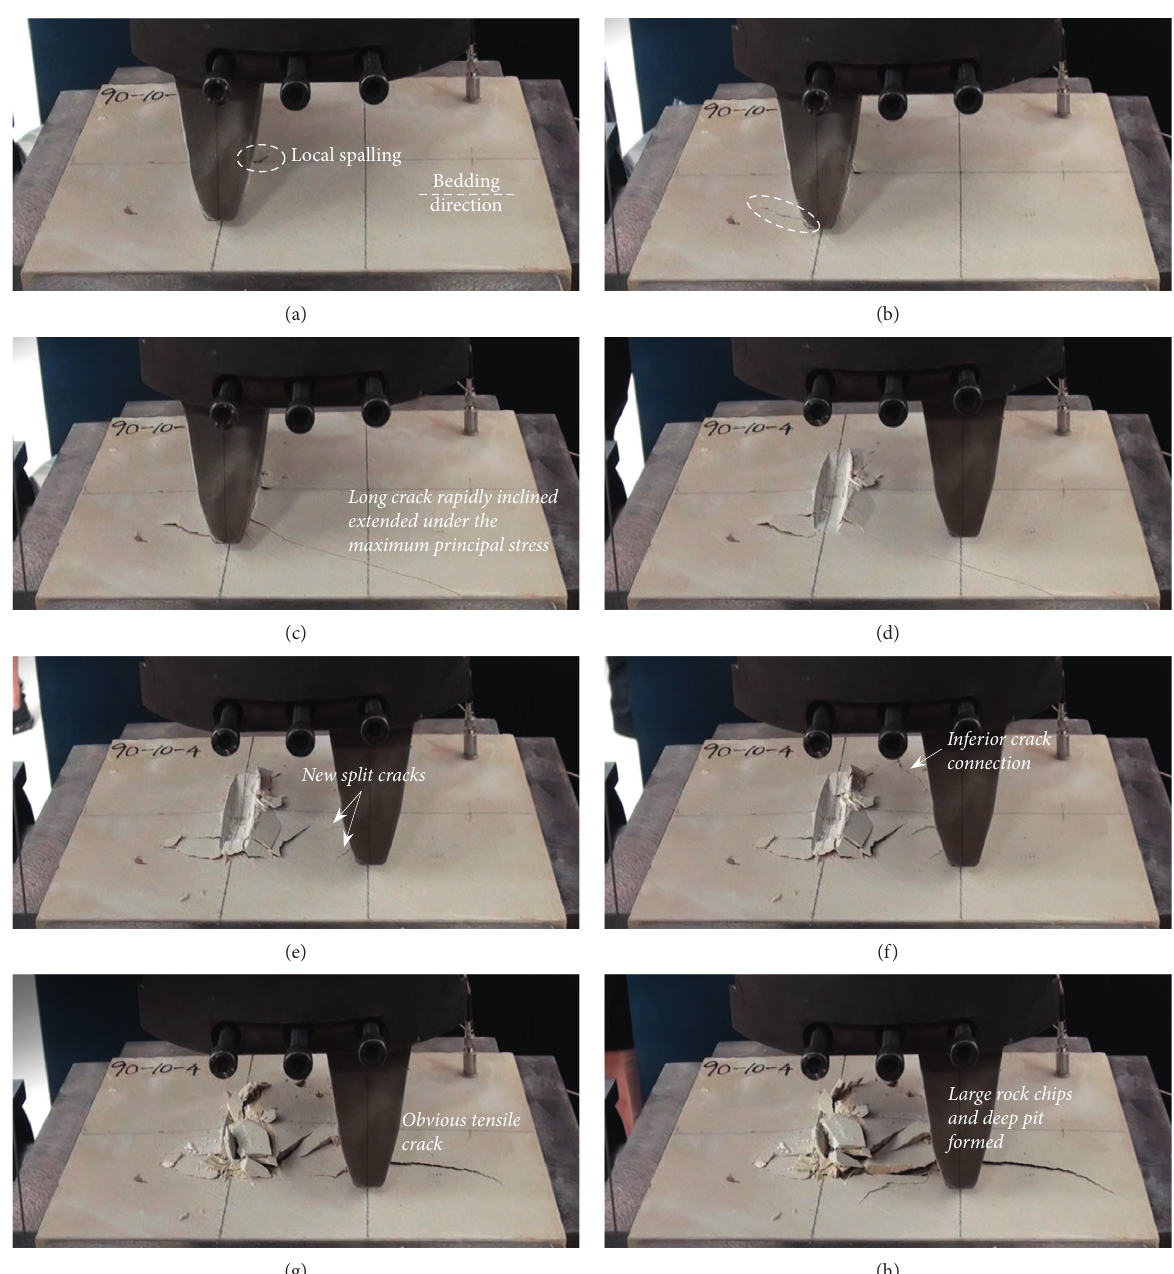
Figure 11: Surface crack evolution of the α � 90 ° specimen under a maximum principal stress of